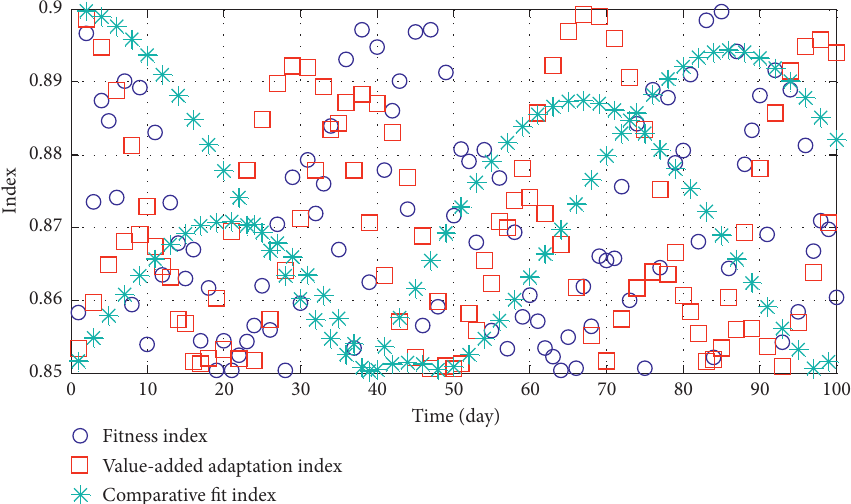
Figure 8: The analysis results of the overall model fit of the maturity scale.